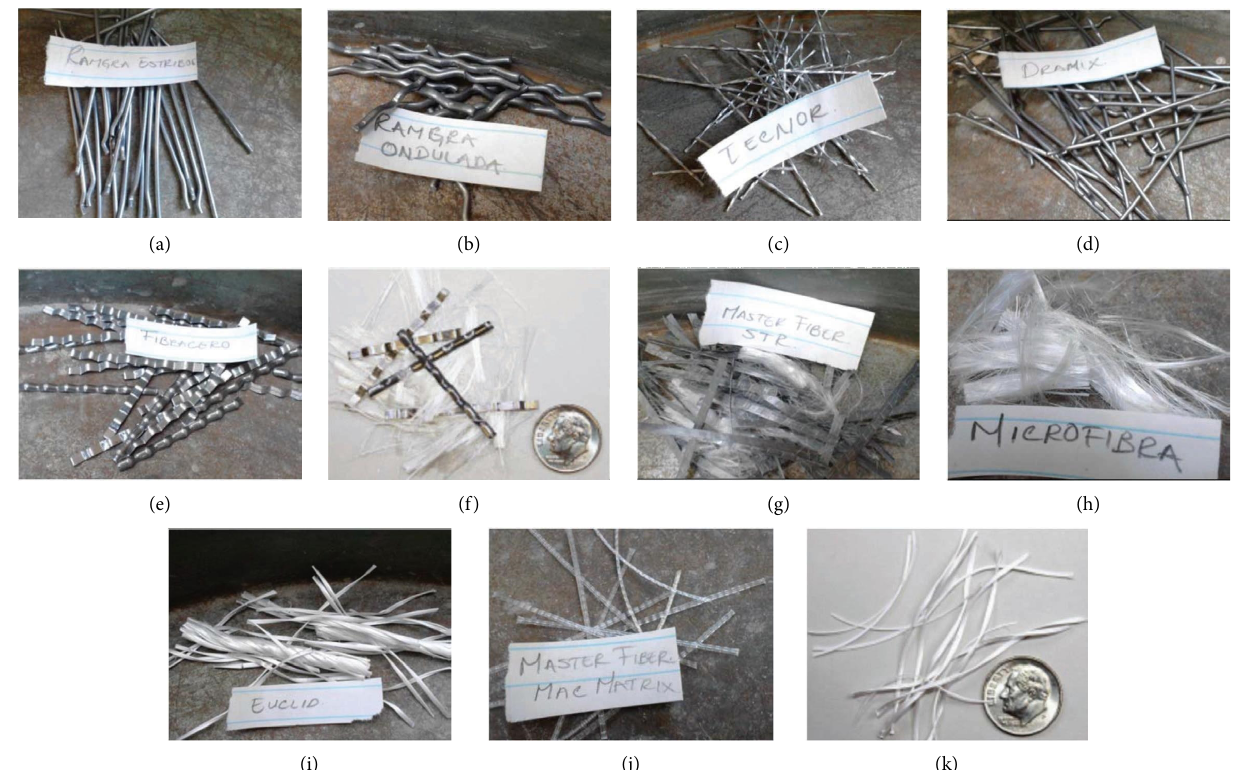
Figure 1: (a) RAMGRA with hooks. (b) Wavy RAMGRA. (c) TECNOR. (d) DRAMIX. (e) FIBRACERO. (f) NYCONS SF-B (series I). (g) MASTERFIBER STR. (h) MASTERFIBER micro. (i) EUCLID. (j) MAC MATRIX. (k) NYCON XL-100 (series